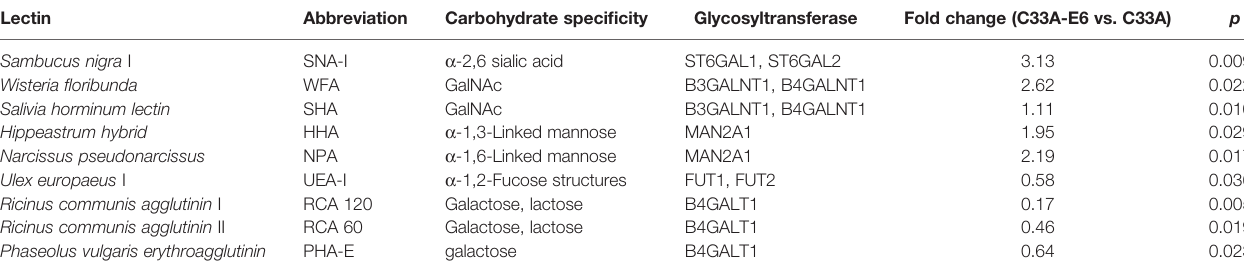
TABLE 2 | Differences in glycan patterns between C33A and C33A-E6 cells by lectin microarray analysis.